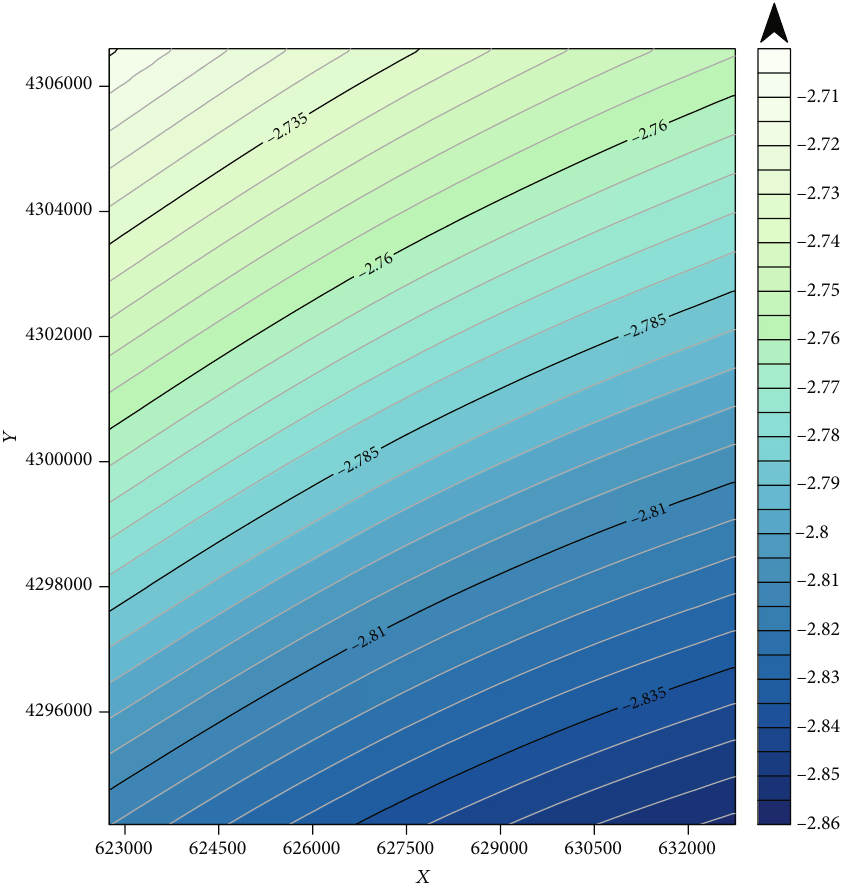
Figure 3: Velocity distribution isogram along the northern direction within the well fi eld